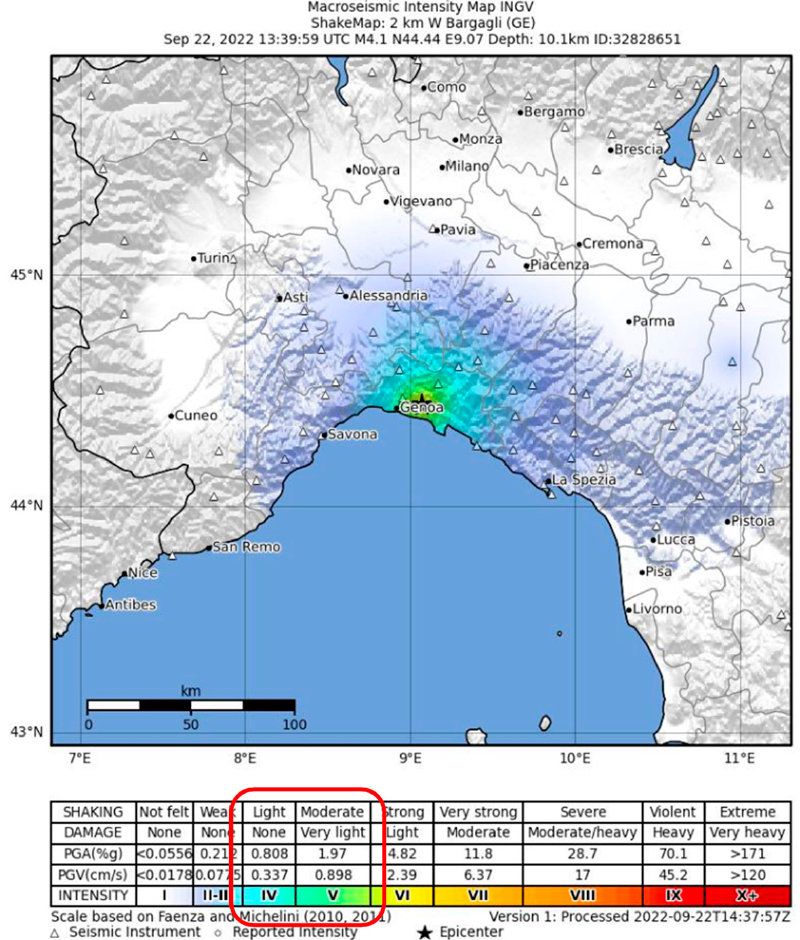
Figure 8. Shaking map of the 22 September 2022 earthquake that occurred in Bargagli (source: INGV). In Figure 9, a map of Bargagli dating back to 1980 and taken from Geoportale (http: //www.pcn.minambiente.it, accessed on 19 January 2023) is compared with the